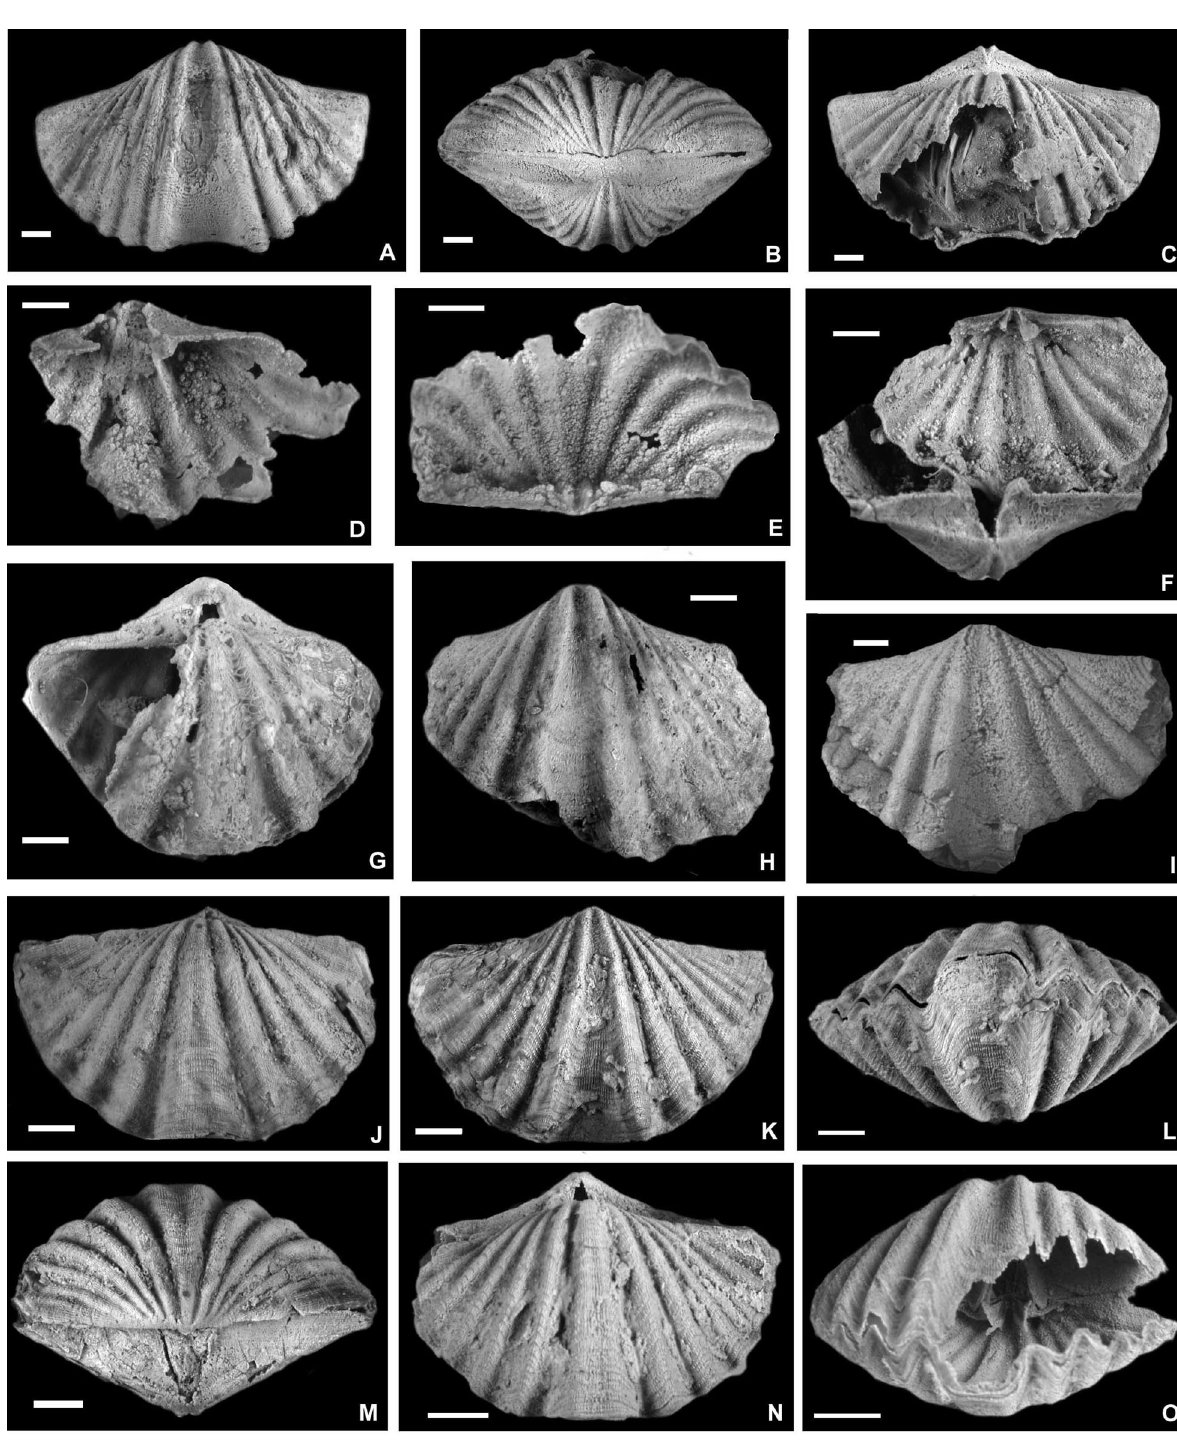
Fig. 11. Striispirifer ? ocissimus sp. nov.; Llandovery, mid-late Aeronian, Niur Formation; A (cid:150) C , I , sample K30, Boghu Mountains; D (cid:150) H , J (cid:150) O , sample S14, Derenjal Mountains; A(cid:150)C, NMW 2011.11G.359, conjoined valves, ventral, anterior and dorsal views showing silicified spiralia; D, NMW 2011.11G.361.1, incomplete ventral valve interior; E, NMW 2011.11G.361.2, oblique posterior view of dorsal valve interior; F, NMW 2011.11G.362, dorsal valve interior and NMW 2011.11G.363, ventral valve interarea; G, NMW 2011.11G.364, broken conjoined valves, dorsal view; H, NMW 2011.11G.364, broken conjoined valves, ventral view; I, NMW 2011.11G.360, broken conjoined valves, ventral view; J(cid:150)M, NMW 2011.11G.365, conjoined valves, dorsal, ventral and anterior views; N, O, NMW 2011.11G.366, conjoined valves, posterior and dorsal